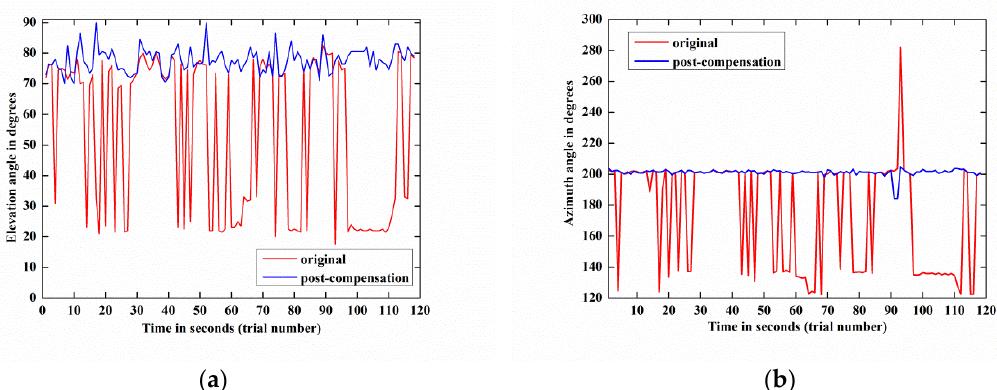
Figure 13. 2-D DOA estimation performance comparison between the original and post-compensation of weak target signal-2 by 118 trials: ( a ) Elevation angle; ( b ) Azimuth angle.